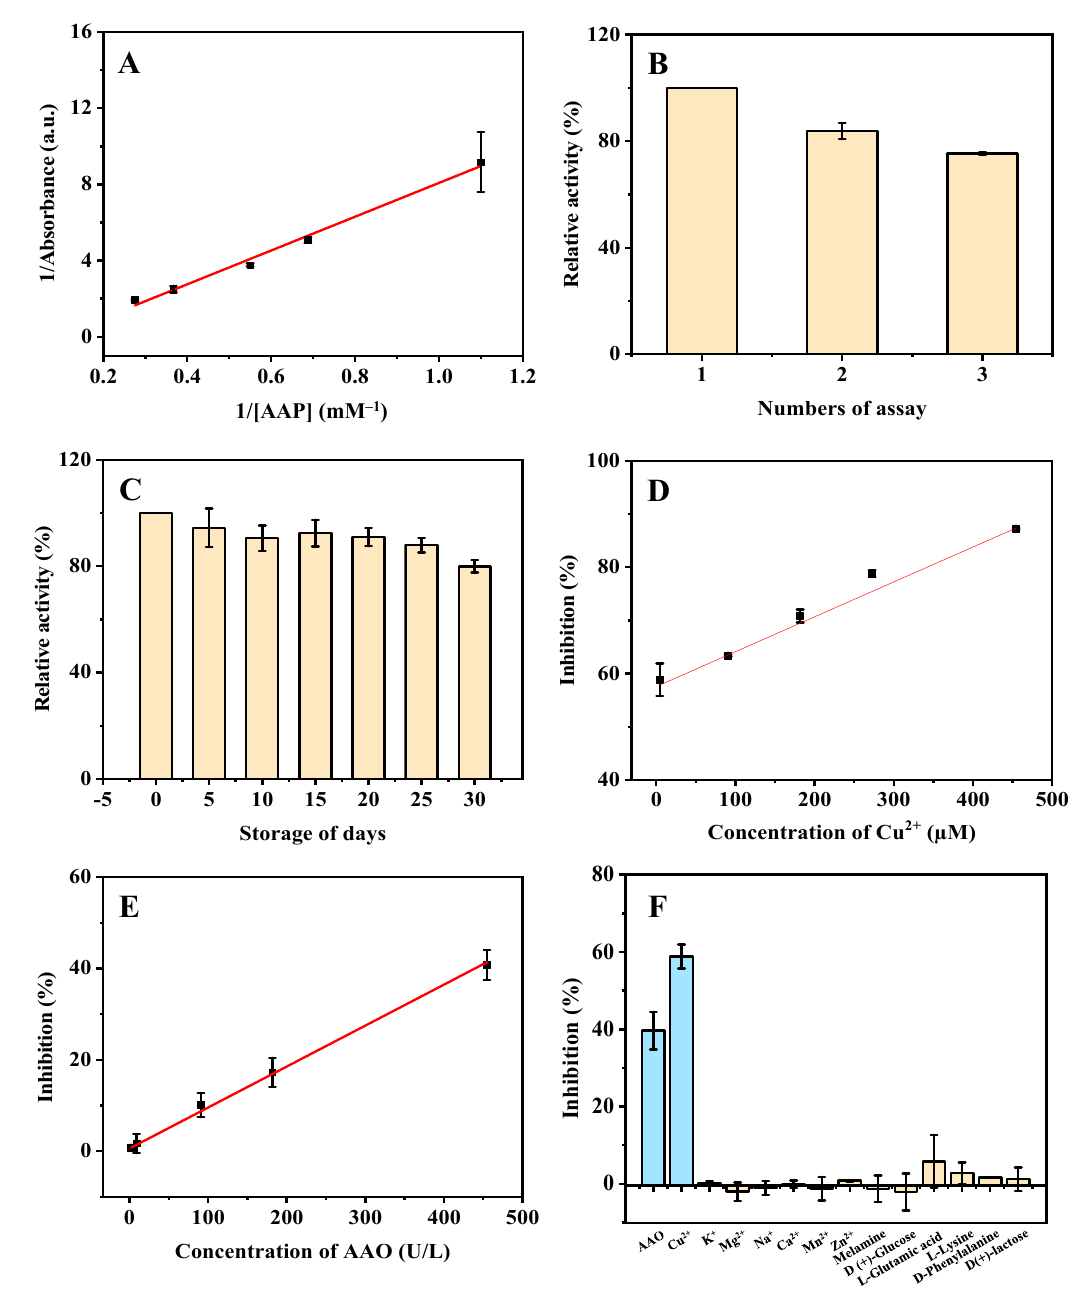
Figure 6. Double reciprocal plot ( A ), the reusability ( B ), storage stability ( C ), linearity of Cu 2+ ( D ) and AAO ( E ), and the selectivity ( F ) for the detection of Cu 2+ and AAO based on the ALP-like activity of ZIF-8 under the optimized conditions. ZIF-8, 4 mg; buffer pH, 8.0; reaction time, 12 min; centrifugation time, 3 min for A – F ; AAP concentrations are from 0.9 to 3.6 µM for A ; Cu 2+ concentrations are from 4.5 to 454.5 µM for D ; AAO concentrations are from 2.3 to 454.5 U/L for E . The concentrations of Cu 2+ , AAO, and other substances are 4.5 µM, 454.5 U/L, and 90.9 µM for F , respectively.